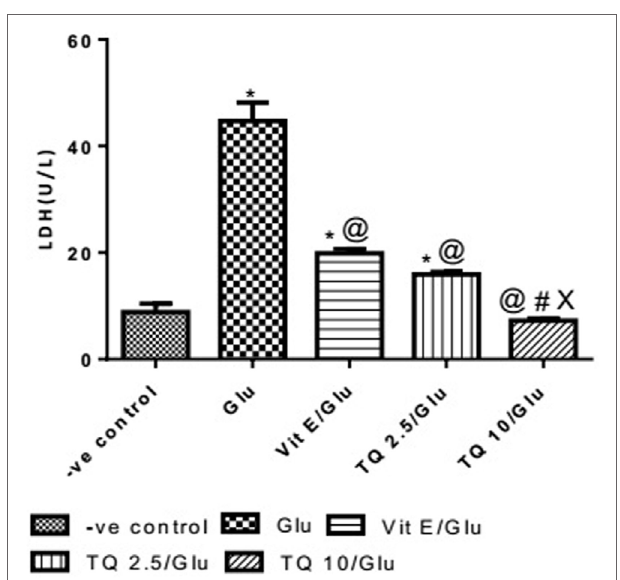
FigUre 2 | Effect of Glu, Vit E/Glu, TQ2.5/Glu, and TQ10/Glu on the fourth day mean escape latency in the Morris water maze test. Glu was injected i.p. as a single dose for 7 days. TQ and Vit E were injected as a single dose for 7 days. Each value represents the mean value of 12 rats ± SEM. Statistics carried